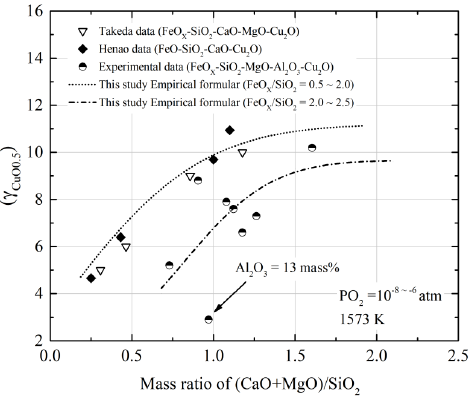
Figure 6. Comparison of the empirical formula with the reported and obtained Cu 2 O activity coef- ficients.